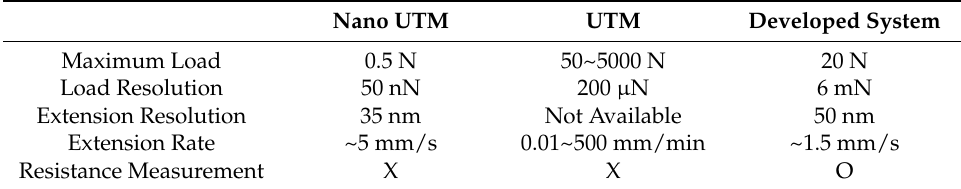
Table 1. General specifications of Nano UTM, UTM, and the developed system. Nano UTM